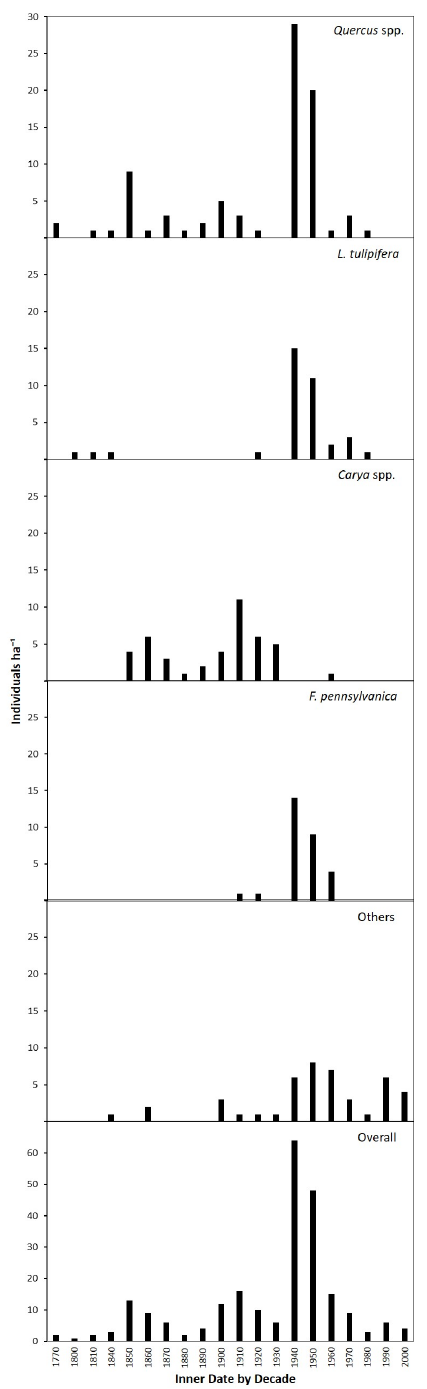
Figure 6. Age structure by group in a multi-cohort forest on the Oakmulgee Ranger District of the Talladega National Forest. Note decades without an inner date record are not included. See Table 1 for a list of species included in the others group.